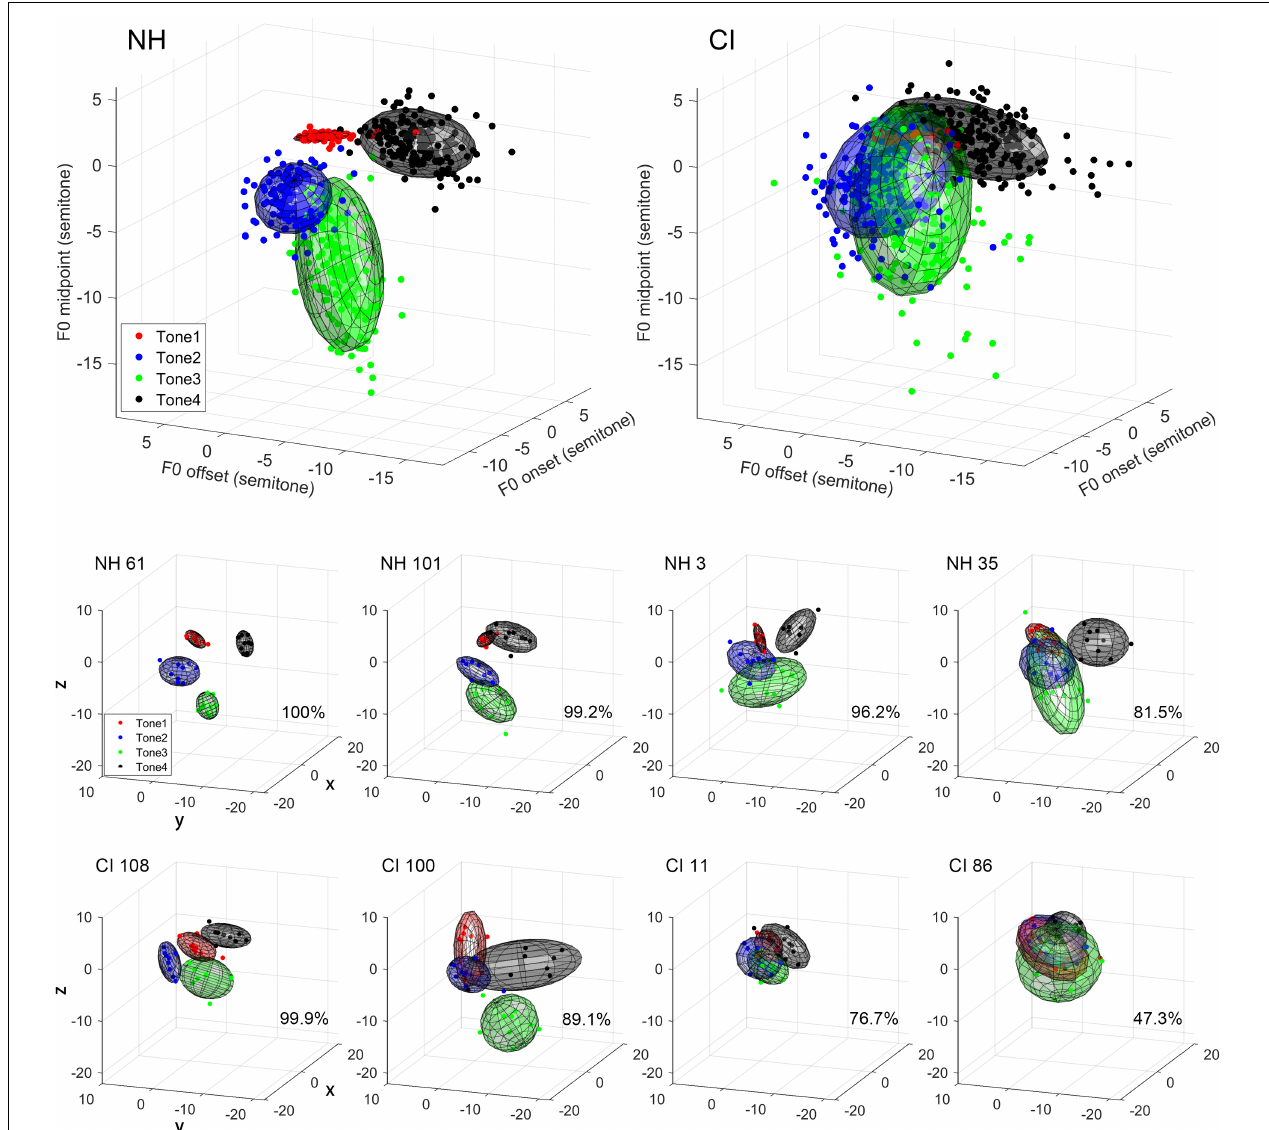
FIGURE 2 | Tone ellipsoids based on F0 onset, midpoint, and offset values (3D method). Upper panels: Tone ellipsoids of the NH (left) and CI (right) groups. Each symbol represents the mean data of one subject. Lower panels: Tone ellipsoids of individual representative subjects. For either NH or CI group, four subjects were randomly selected based on their mean tone differentiability scores in the interval of 75th–100th, 50th–75th, 25th–50th, and 0–25th quantiles in the respective groups. Mean differentiability score is displayed on the lower right corner. Each data point represents F0 onset–midpoint–offset values of a produced token. Four different colors represent four different tone types as indicated in the